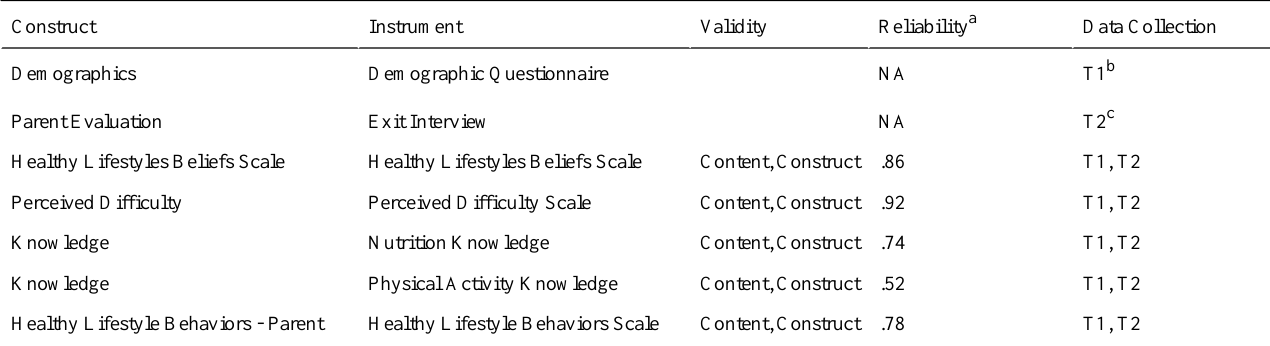
Table 3. Summary of data